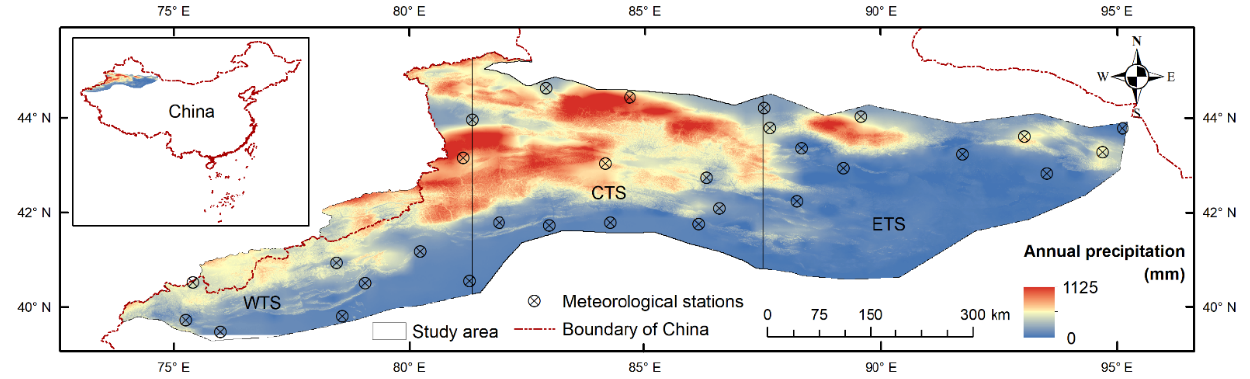
Figure 1. Location of the Tianshan Mountains and the spatial distribution of average annual precipitation from 1979 to 2020.